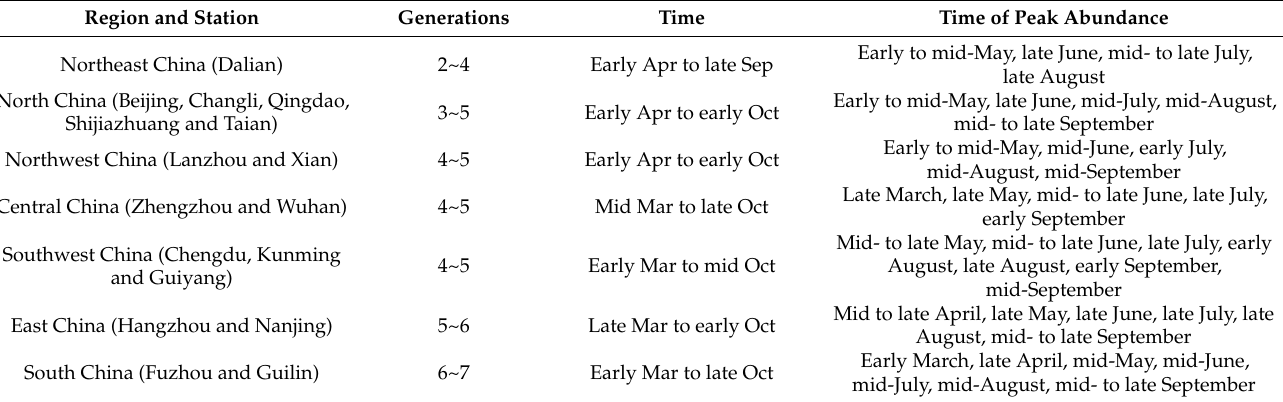
Table 1. The generation and peak abundance of G. molesta in